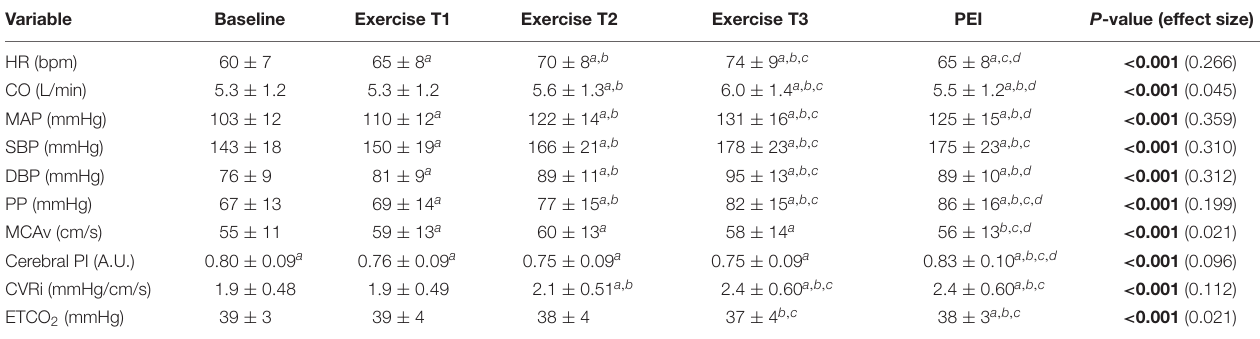
FIGURE 3 | Percent change (% change) from baseline values in cardiovascular and cerebrovascular variables during each tertile of isometric handgrip exercise (EX T1, EX T2, EX T3, respectively) followed by a period of post-exercise ischemia (PEI). Means and individual data presented. The solid black line represents mean values. (A) % change in heart rate, HR; (B) % change in mean arterial pressure, MAP; (C) % change in middle cerebral artery blood velocity, MCAv; (D) % change in cerebrovascular resistance index, CVRi. Significance is indicated by the following: b P < 0.05 vs. exercise T1, c P < 0.05 vs. exercise T2, d P < 0.05 vs. exercise T3 (n = 68; One-way repeated measures ANOVA with Bonferroni post hoc testing). TABLE 2 | Cardiovascular and cerebrovascular variables during isometric handgrip exercise and post-exercise ischemia. Variable Baseline Exercise T1 Exercise T2 Exercise